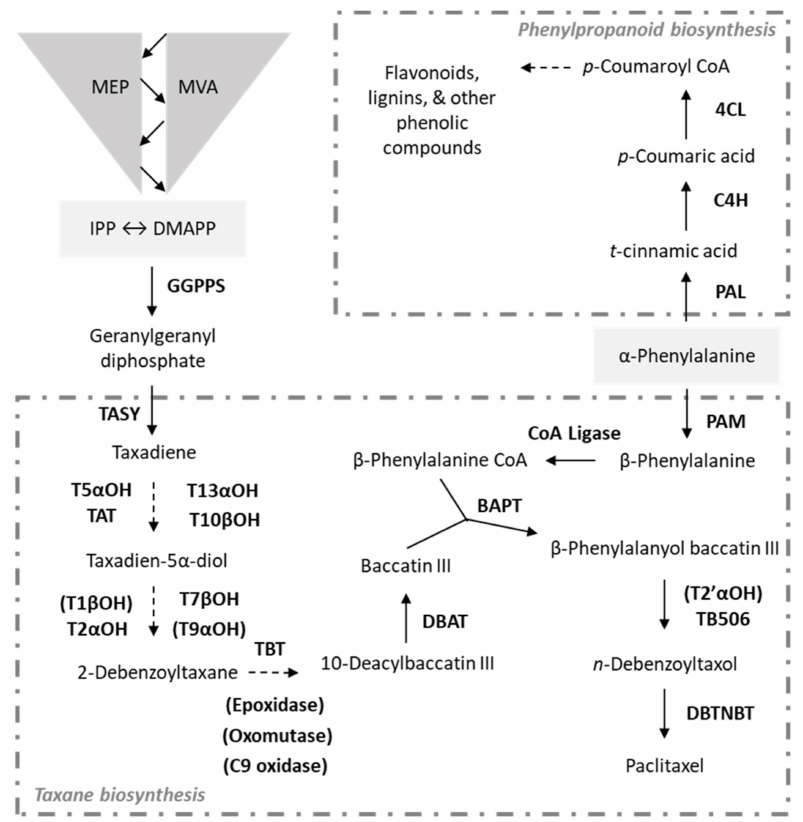
Figure 1. Metabolic map for key specialized metabolic pathways in Taxus cell culture. Paclitaxel biosyn- thesis feeds from the interchanging plastidic MEP and cytosolic MVA pathways. Hypothesized and unidentified enzymes are denoted with parentheses. Enzyme abbreviations: geranylgeranyl pyrophos- phate synthase (GGPPS), taxadiene synthase (TASY), taxane 5 α -hydroxylase (T5 α OH), taxadien-5 α